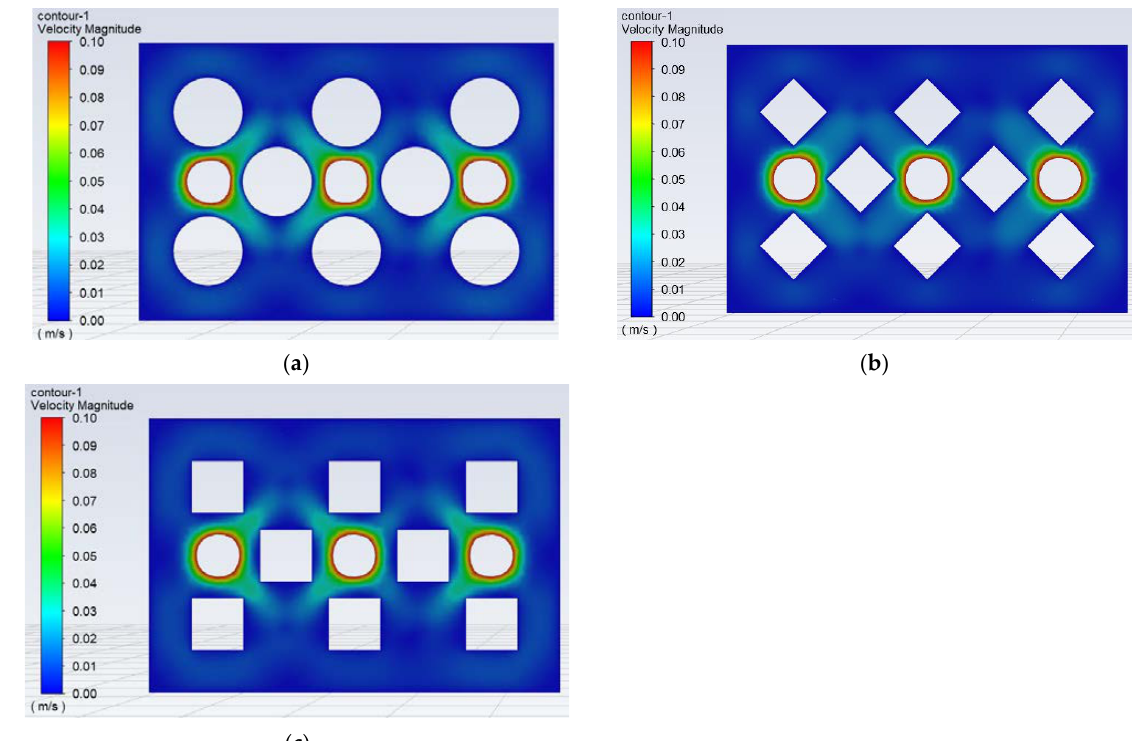
Figure 11. Velocity contour in the lower microchannel layer: ( a ) round; ( b ) diamond; and ( c ) rectangle.